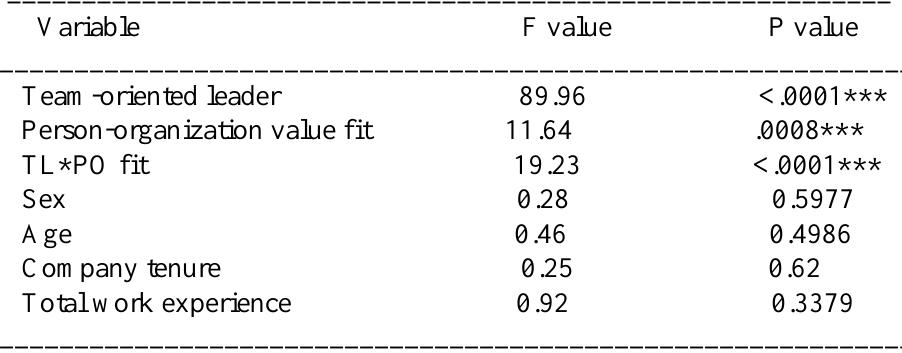
Table 3: Dependent Variable = Employee Participation